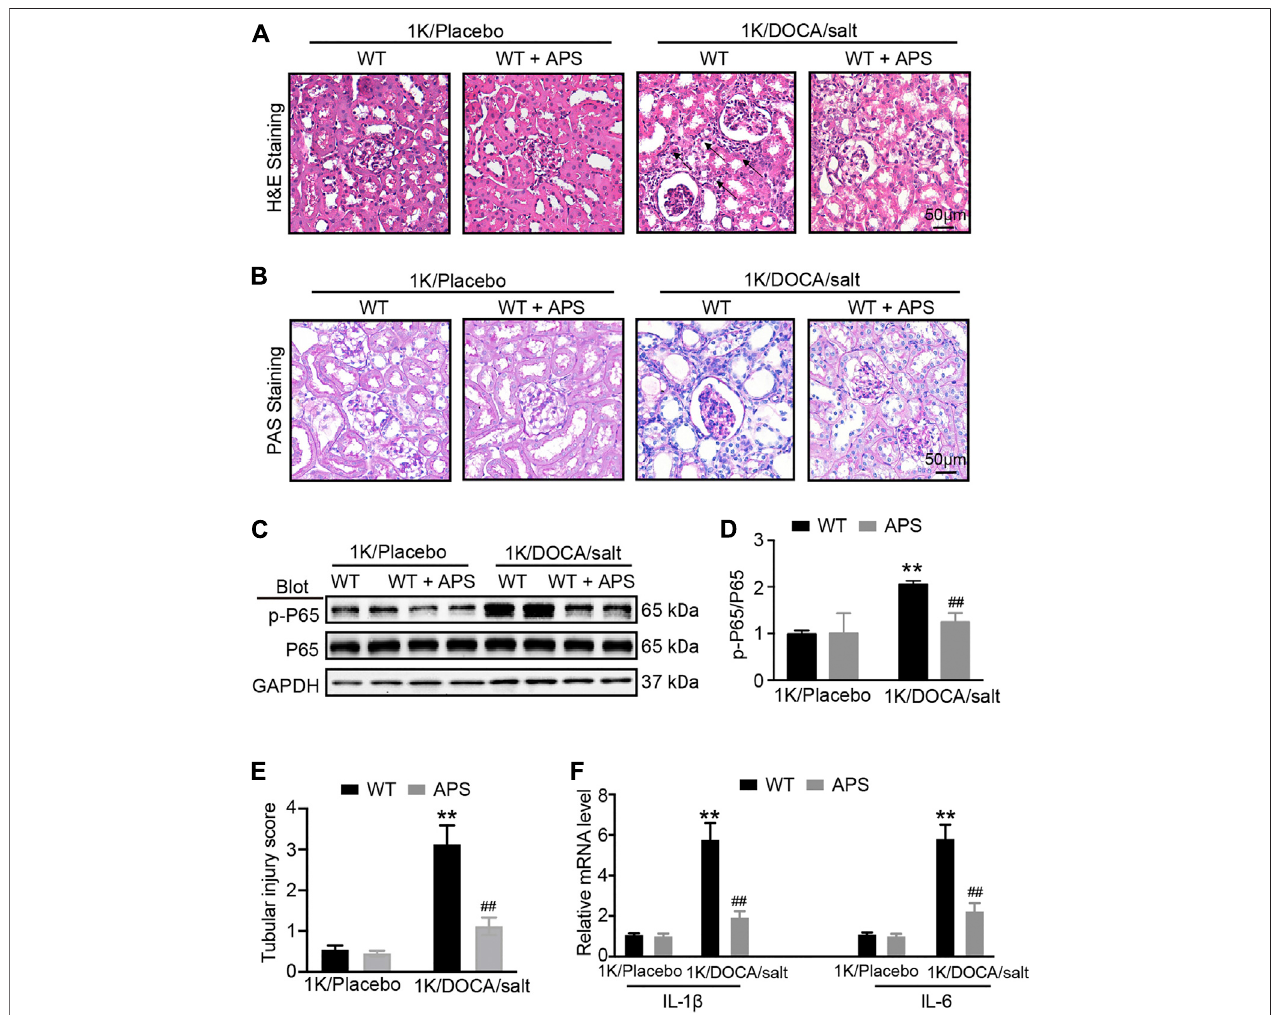
(D) Quanti fi cation of protein bands ( n (cid:1) 4). (E) Tubular injury score was computed from the percentage of damaged tubulars. Based on the different degree of tubular injury, the score was divided into 0, normal; 1, < 10%; 2, 11 – 25%; 3, 26 – 75%; 4, > 75% of the observed tubules. (F) qPCR analysis of IL-1 β and IL-6 mRNA expression levels in the kidney ( n (cid:1) 6). ** P < 0.01 versus control mice. ## P < 0.01 versus DOCA + APS